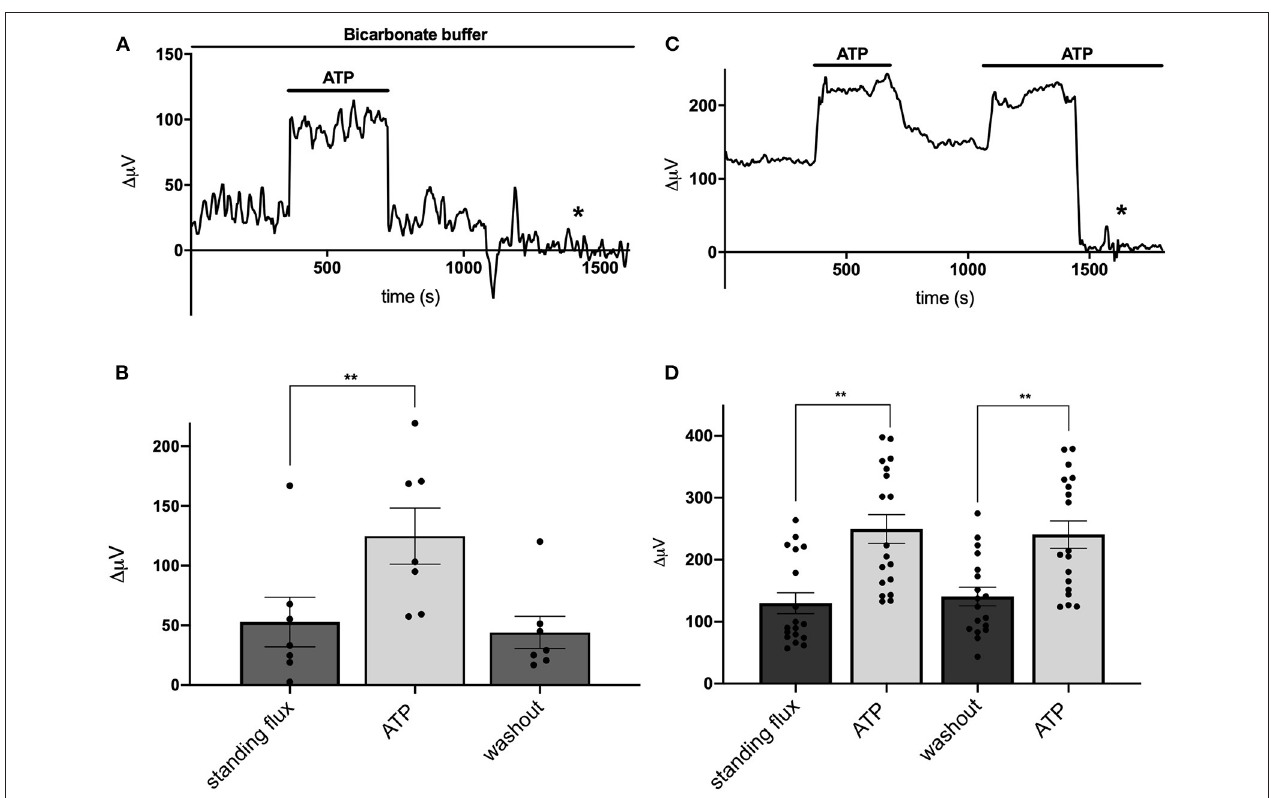
FIGURE 2 | Responses of cells identified as astrocytes cultured from mouse hippocampus to applications of 100 µ M ATP. (A) Response from one cell bathed in saline buffered with 26mM bicarbonate to 100 µ M ATP. A standing H + flux of about 30 µ V was observed prior to stimulation. Addition of 100 µ M ATP to the bath solution induced a detectable increase in H + flux. Upon removal of ATP, the H + flux signal returned to its pre-stimulus baseline. From about 1,250s until the end of the trace (indicated by the asterisk), the electrode was moved to a position 600 µ m above the cell, a location where the differential response should be close to 0 µ V. (B) Average H + flux from seven cells bathed in 26mM bicarbonate saline before, during and after the application of 100 µ M ATP; N = 7. (C) Response from one cell bathed in saline containing 1mM HEPES as the primary extracellular pH buffer to applications of 100 µ M ATP. Prior to challenge with ATP, the cell displayed a standing H + flux signal of abut 120 µ V. Addition of 100 µ M ATP induced an increase in the H + flux signal. Removal of ATP resulted in the return of the H + flux signal near to its original pre stimulus level. A second application of 100 µ M ATP again led to a marked increase in H + flux. At about 1,450s, the electrode was repositioned 600 µ m above the cell (designated by the asterisk); at this background location, sampling between two points 30 µ m apart gave a differential signal close to 0 µ V. (D) Average H + flux signals from cells bathed in saline containing 1mM HEPES as the primary extracellular pH buffer; N = 18. **indicates P <